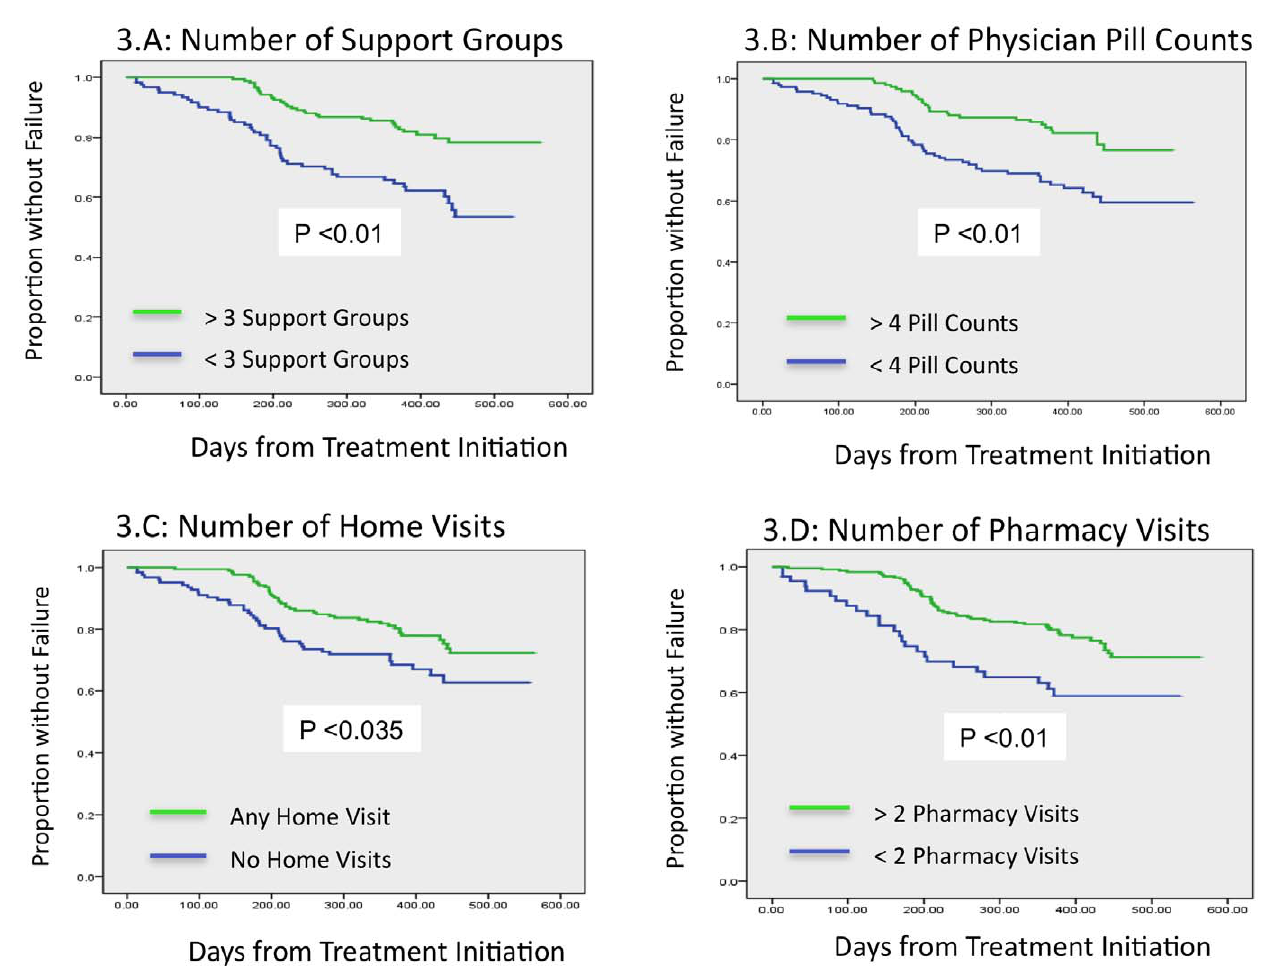
Figure 3. Time to Treatment Failure Categorized by Interventions. Kaplan Meier plots of time to treatment failure stratified by: A) participation in two or more support group meetings; B) having four or more unannounced pill counts by primary care provider; C) at least one home visit; D) having two or more counseling sessions by a pharmacist.